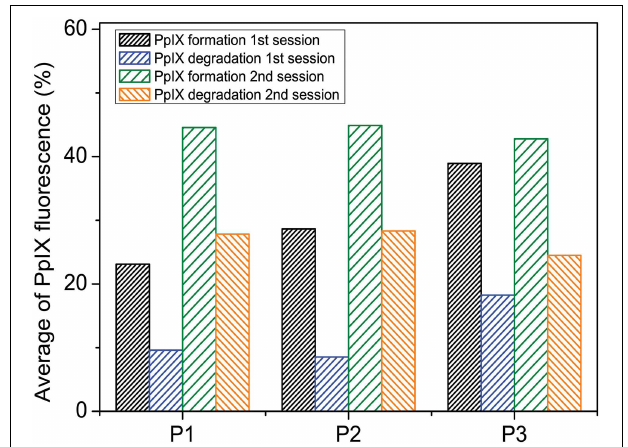
FIGURE 9 | Mean value of red pixels in fluorescence images of different patients (P1, P2, and P3), comparing the formation and degradation in the first and second PDT